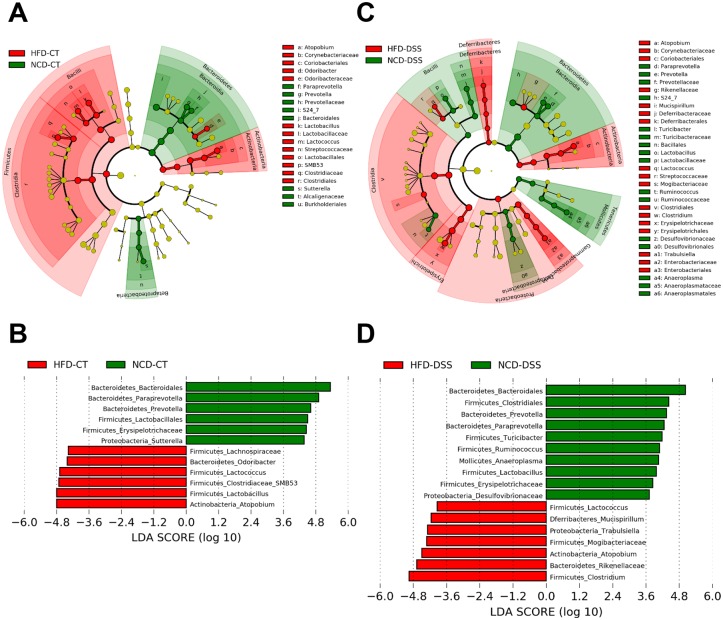
Linear discriminant analysis (LDA) effect size (LEfSe) analysis of gut microbiota changes following consumption of a high-fat diet (HFD) and dextran sodium sulfate (DSS) treatment. Effect of diet.(A and B) Normal chow diet (NCD) control-CT vs. HFD-CT mice. (C and D) NCD-DSS vs. HFD-DSS mice. The phylogenetic tree and histogram show LDA scores calculated for differences in genus-level abundance between mice fed different diets. NCD-CT, NCD-fed mice without DSS treatment; NCD-DSS, NCD-fed mice with DSS treatment; HFD-CT, HFD-fed mice without DSS treatment; HFD-DSS, HFD-fed mice with DSS treatment (n = 5 each). As in Fig 9, the colors represent which group the taxa was more abundant compared to the other group. The LDA scores of the HFD-CT and HFD-DSS were negative (Fig 10B), while those of the NCD-CT and NCD-DSS were positive. The absolute values of the effect size indicate the scale of the difference between 2 groups regardless of the positivity or negativity.